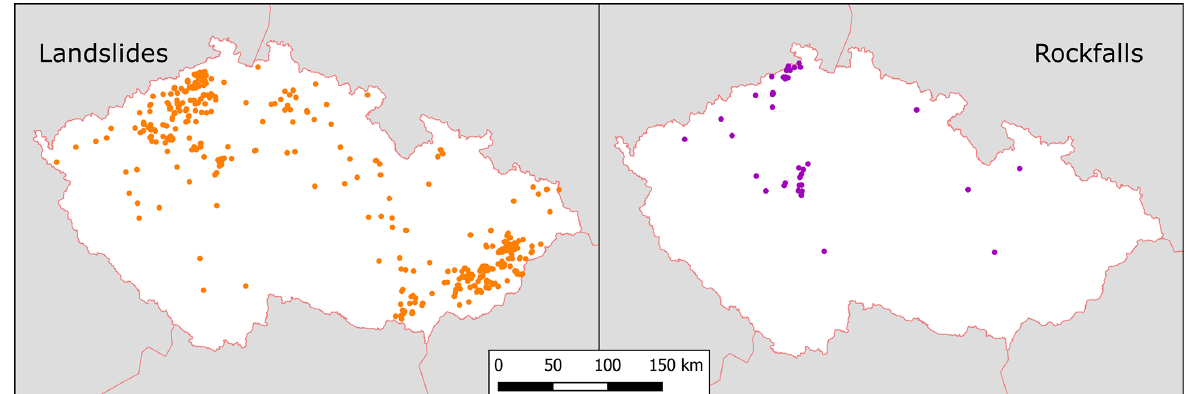
Figure 7. Landslide and rockfall distribution.